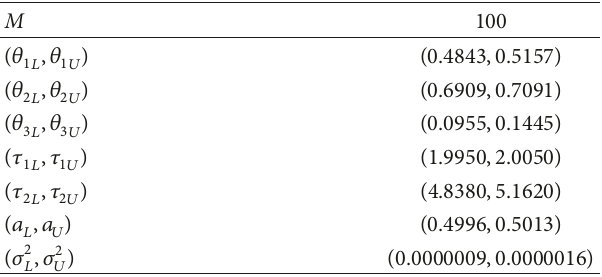
Table 9: Table showing the 95 % confidence intervals for parameters 𝜃 , 𝜃 ,𝜃 , 𝜏 ,𝜏 ,𝑎 , and 𝜎 2 in DLDE with two 1 2 3 1 2